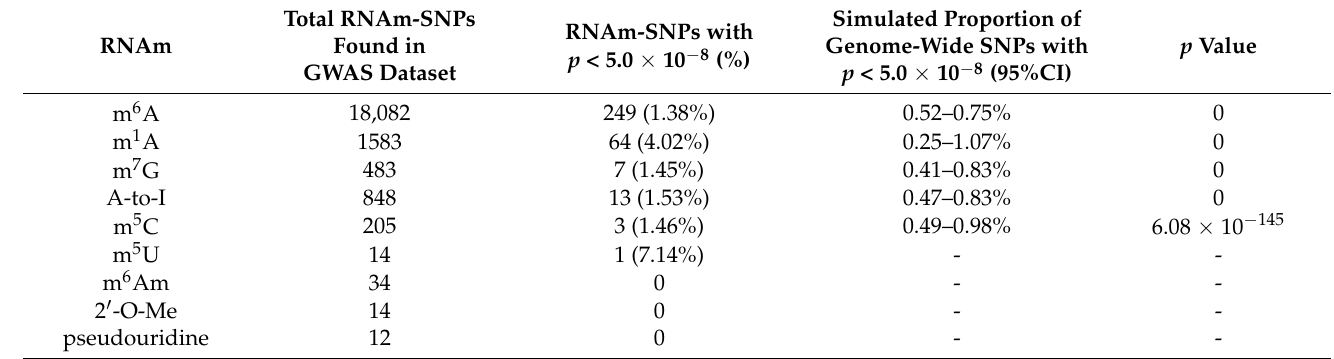
Table 1. Proportion of significant RNAm-SNPs in eBMD GWAS